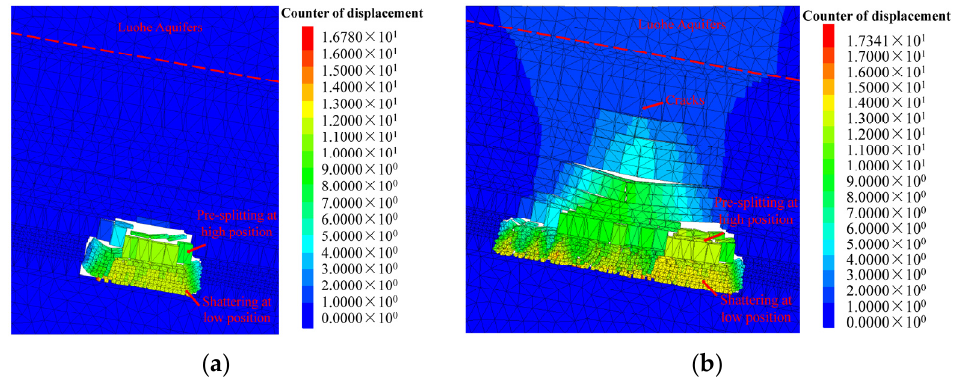
Figure 9. Roof caving process by pre-splitting at high position and shattering at underlying position at the mining length of ( a ) 50 m and ( b ) 100 m, respectively.